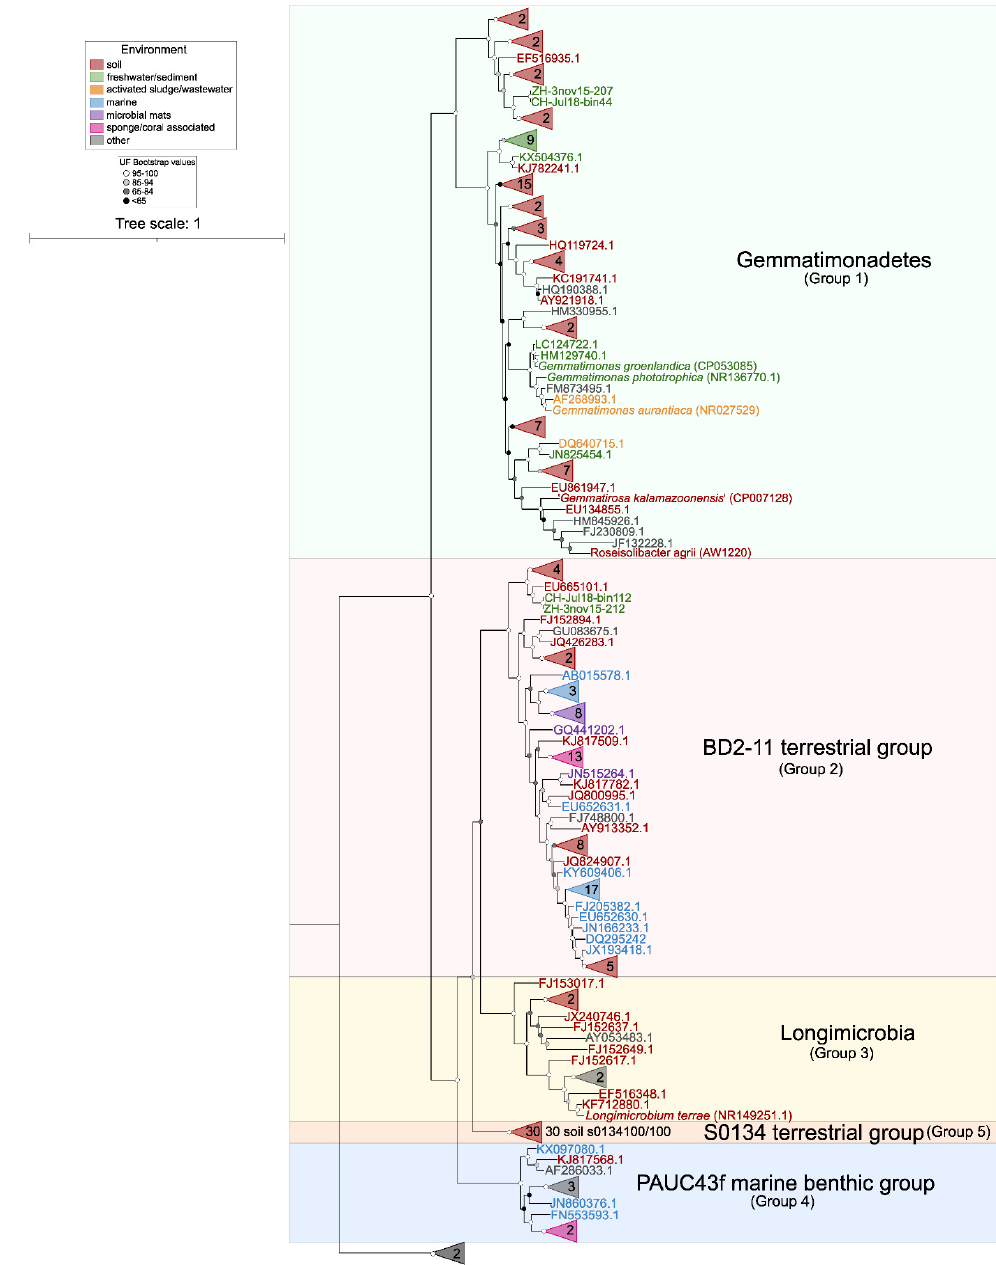
Figure 5. Maximum-likelihood phylogeny of 16S rRNA genes of Gemmatimonadota sequences re- covered from the SILVA SSU v138 database (in total, 169 sequences, >1200 bp, sequence quality >94%, downloaded on 23 November 2021), 36 16S rRNA gene sequences whose accession numbers were taken from [22,59], and 12 sequences taken from [18]. All of the accession numbers are provided as Supplement Table S1. The phylogenetic tree was made with IQ-TREE [72,73], the TIM3 + F + I + G4 substitution model (chosen as the best-fitting model by ModelFinder [74]), and 1000 ultrafast boot- strap replicates. The sequences are colored based on the environment from which they originate (left legend). Numbers at collapsed branches indicate the number of sequences. All five class-level groups are indicated through vertical delimiters in the right part of the figure. The strength of support for internal nodes (assessed by ultrafast bootstrapping) is shown through gray-scale circles (left legend). Two sequences belonging to Fibrobacterota ( Fibrobacter succinogenes and Fibrobacter intestinalis ) were used as an outgroup. The phylogenetic tree was visualized using iTOL [75] and edited in Inkscape (version